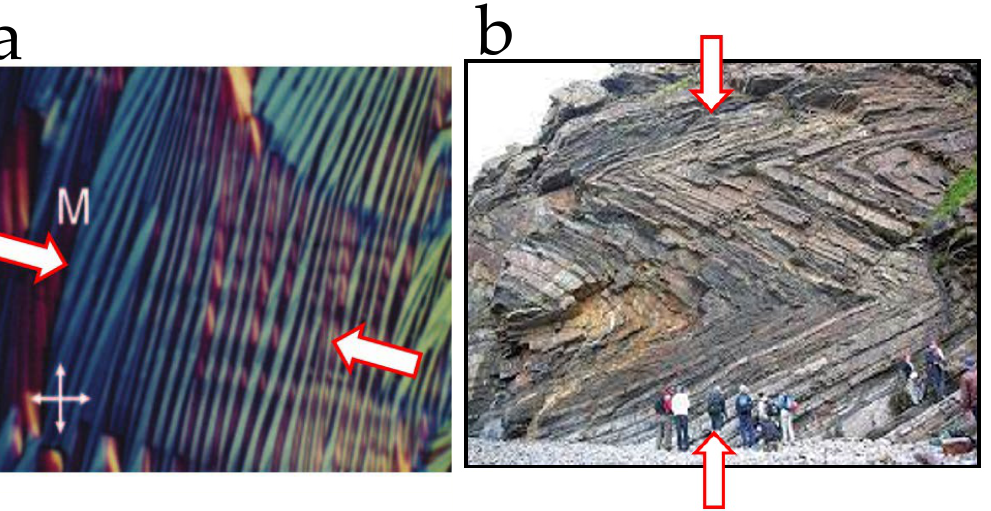
Figure 7. Herringbone textures. ( a ) shows the optical texture of the M phase of Intal. ( b ) shows the chevron distortion of strata in the cliff at Millhook Haven in North Cornwall Cornwall [20]. The arrows indicate the direction of the compressive stress.